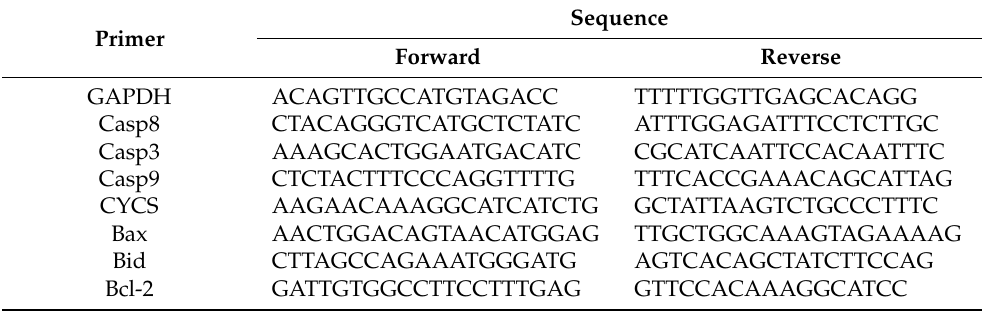
Table 1. The sequence of primers used in this work, including GAPDH, Casp8, Casp3, Casp9, CYCS, Bax, Bid, and